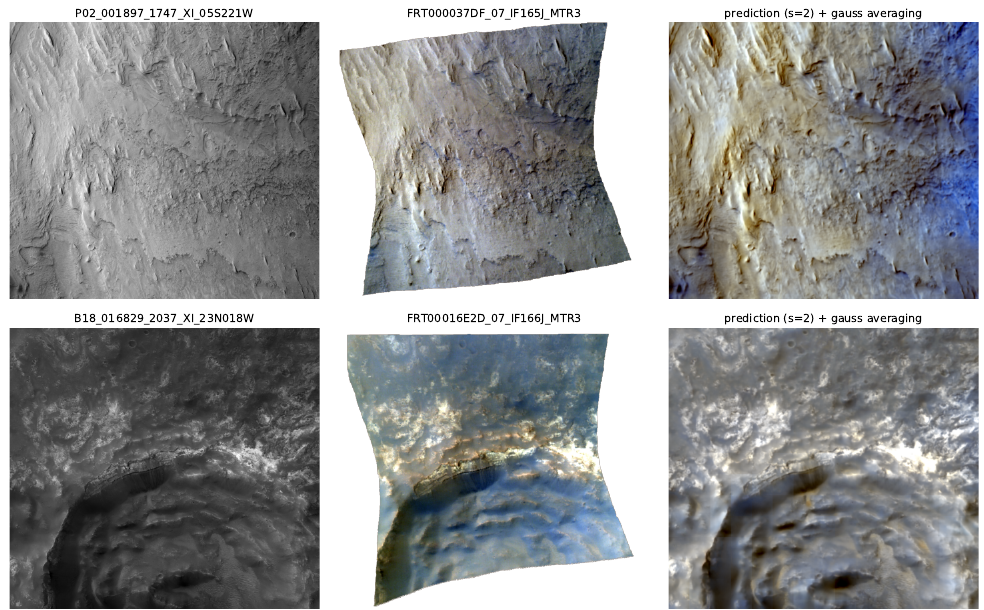
Figure 21. Full EVC image predictions of the proposed approach from the test set. From top to bottom: Gale crater test CTX-CRISM pair and Mawrth Vallis test CTX-CRISM pair.